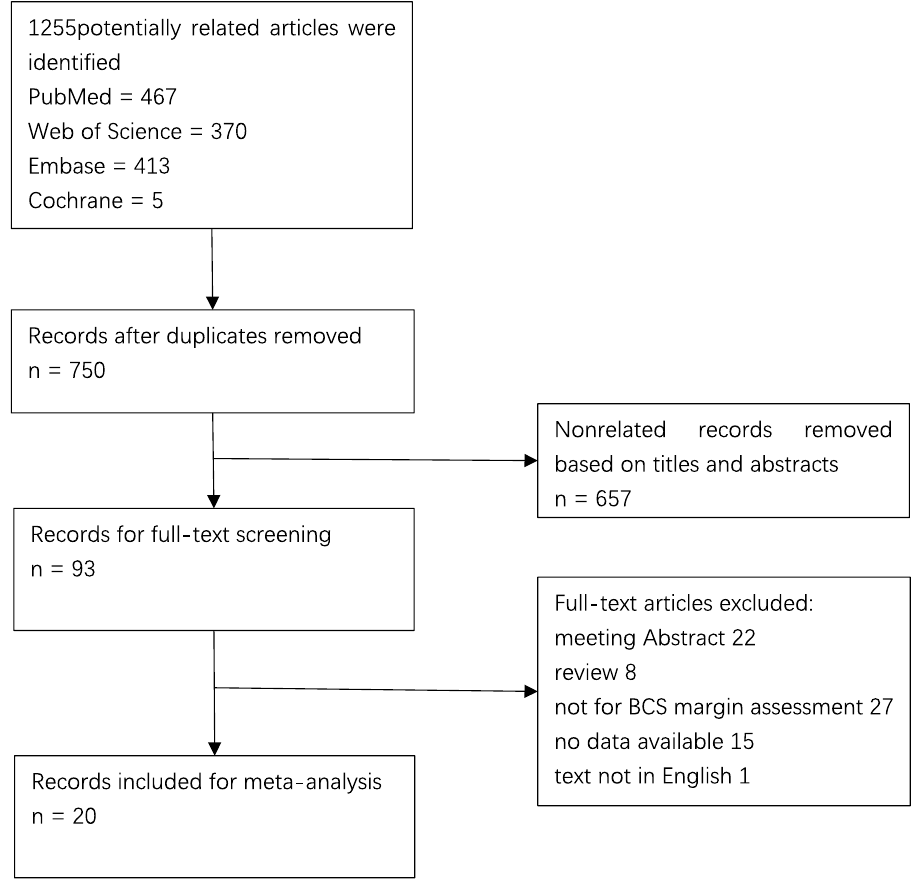
Figure 1. Flowchart illustrating the selection of the